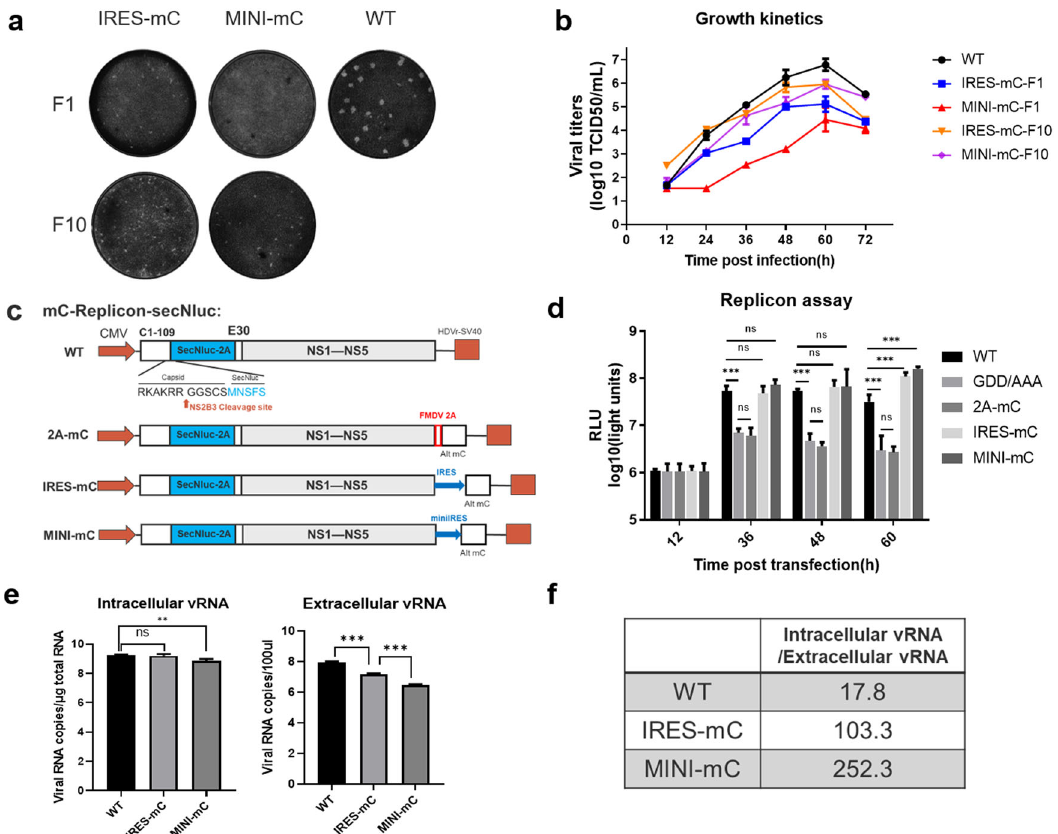
Fig. 2 In vitro properties of recombinant viruses ectopically expressing CP. a Plaque morphology and b growth kinetics of the CQW1-IRES- mC and CQW1-MINI-mC viruses on BHK-21 cells. c This panel depicts the DNA-based replicons expressing secretory NLuc (mC-Replicon- SecNLuc) used in panel d . Only 1 – 109 aa of CP and the last 30 residues of the E protein were retained for replicons. A replication-defective replicon (GDD/AAA) with inactivated NS5-GDD motifs was used as a negative control. The effect of these insertions in the 3 ’ UTR on viral RNA replication was veri fi ed via a replicon assay. e RT – qPCR analysis of intracellular/extracellular vRNA. An equal dose (3000 TCID 50 ) of each virus was used to infect BHK-21 cells for 18 h to avoid multiple rounds of infection, and the viral copies in the intracellular or extracellular space were then measured. f Intracellular/extracellular vRNA ratios of WT, IRES-mC, and MINI-mC viruses calculated from e . Three independent experiments are presented as the means and SEMs; signi fi cance was de fi ned by a p -value < 0.05 (* p < 0.05; ** p < 0.01; *** p < 0.001), and ns indicates no signi fi